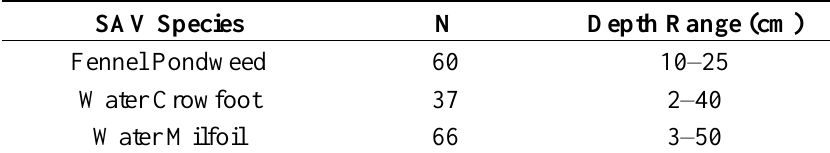
Figure 1. Reflectance spectra of Water Crowfoot at 1.5, 16, and 40 cm below the water surface and the absorption coefficients of water (cm −1 ) for wavelengths between 400 and 1000 nm. Table 1. Submergence depth range and number of spectral samples taken from different macrophyte